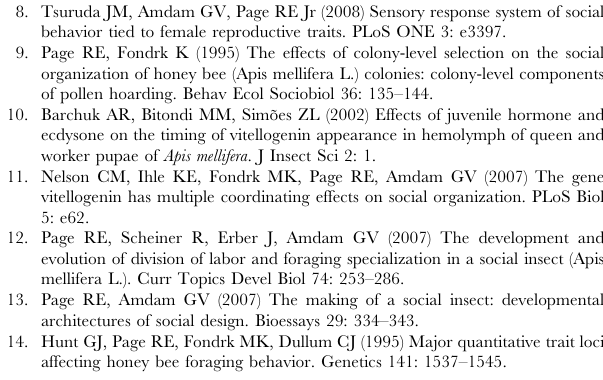
Figure S1 Log transformation of the relative mRNA levels of PDK1 (Mean 6 s.e.m.) in the brain of high (blue bars) (n= 12) and low strain (red bars) bees (n= 12). The mRNA levels are measured as relative quantities (RQ). PDK1 shows no significant difference between high and low strain newly emerged bees and foragers in brain. Figure S2 Log transformation of the relative mRNA levels of HR46 (Mean 6 s.e.m.) in the brain of high (blue bars) (n= 12) and low strain (red bars) bees (n= 12). The mRNA levels are measured as relative quantities (RQ). It shows there is no significant difference in HR46 expression between high and low strain newly emerged bees and foragers in brain. Figure S3 Log transformation of the relative mRNA levels of PAR3 (Mean 6 s.e.m.) in the abdomen of high (blue bars) (n= 12) and low strain (red bars) bees (n= 12). The mRNA levels are